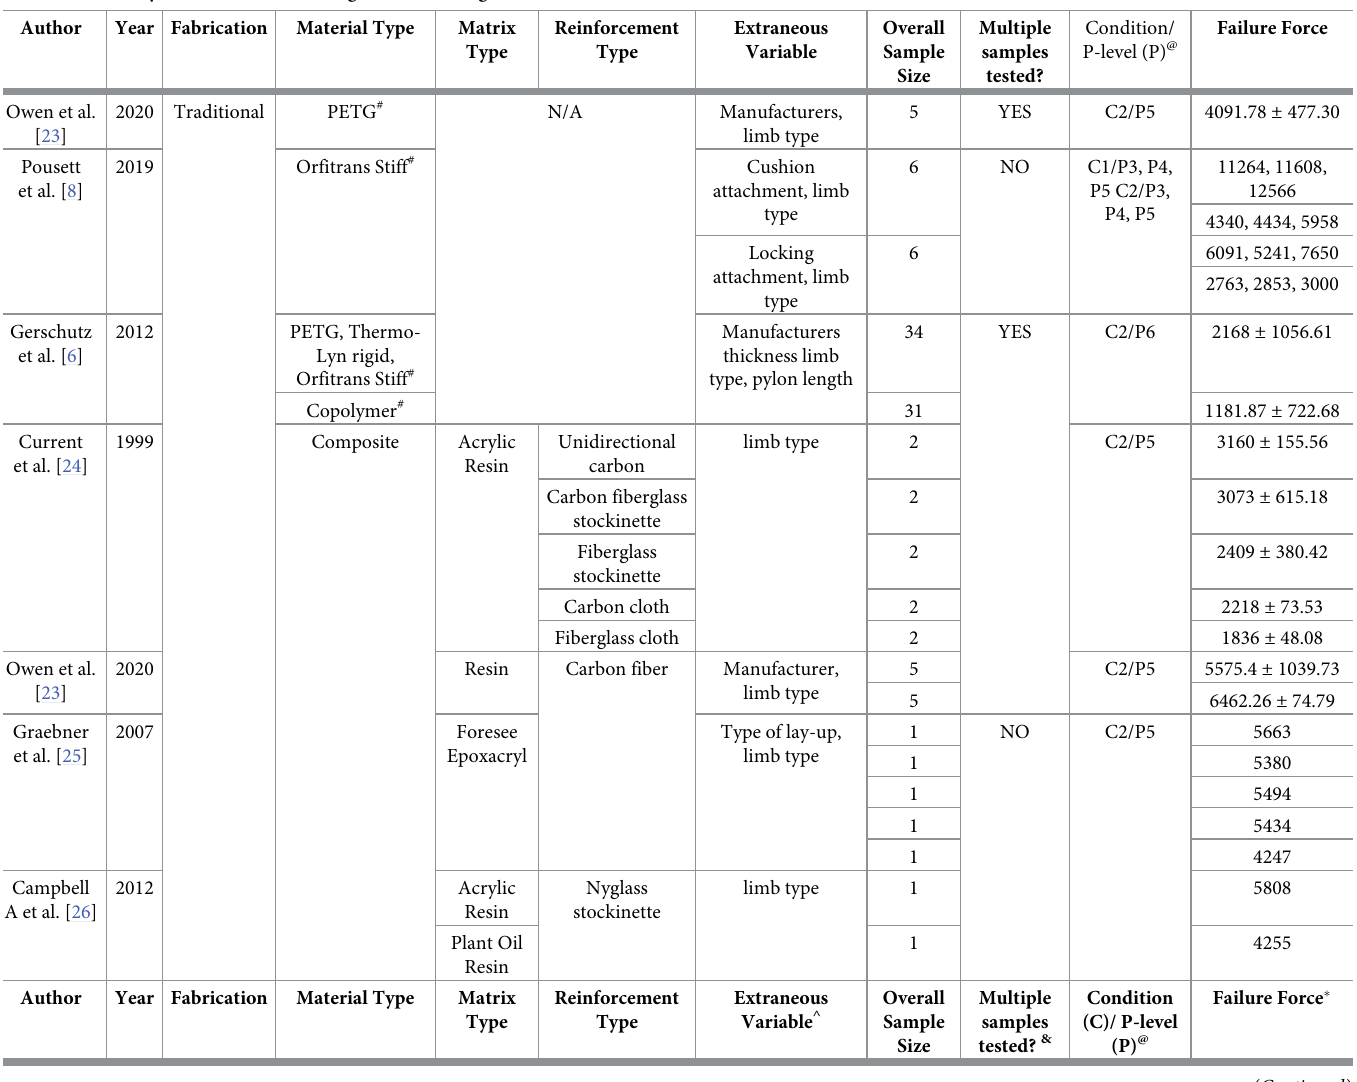
Table 2. Summary of all studies evaluating ultimate strength of 3DS and/or